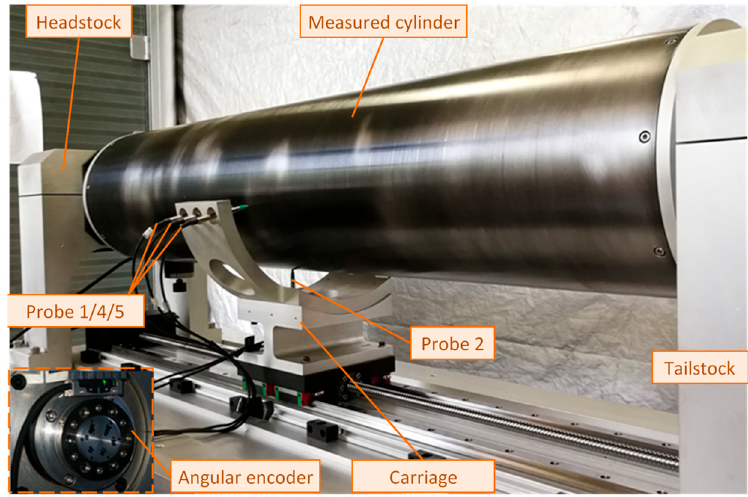
Figure 6. Photograph of the parallel scan EST experimental system.